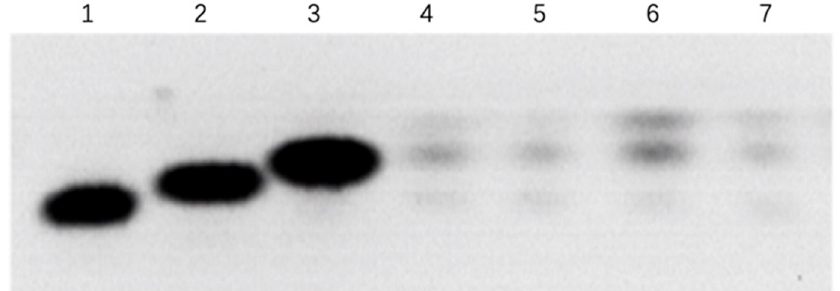
Figure 8. Polyamines intracellular level in PAM cells infected by ASFV. PAM cells were infected by ASFV. At 24 or 48 h post-infection, the cells were harvested and PAM intracellular polyamine levels were detected by the TCL method. Lane (1,2,3) the standard sample of spermidine, spermidine, and putrescine, respectively. Lane (4,6) PAM cells 24 or 48 h p.i. infected by ASFV. Lane (5,7) PAM cells 24 or 48 h mock.